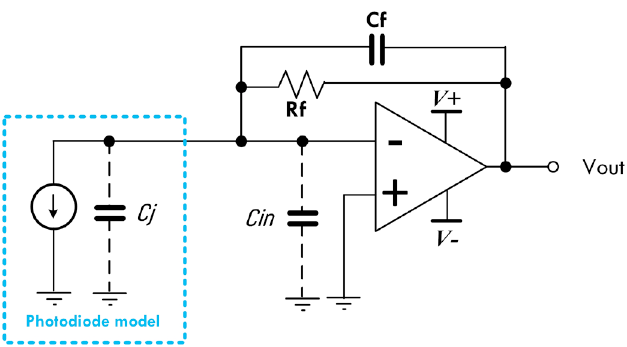
Fig. 1. TIA model, the figure is reproduced version from the original article at [26],